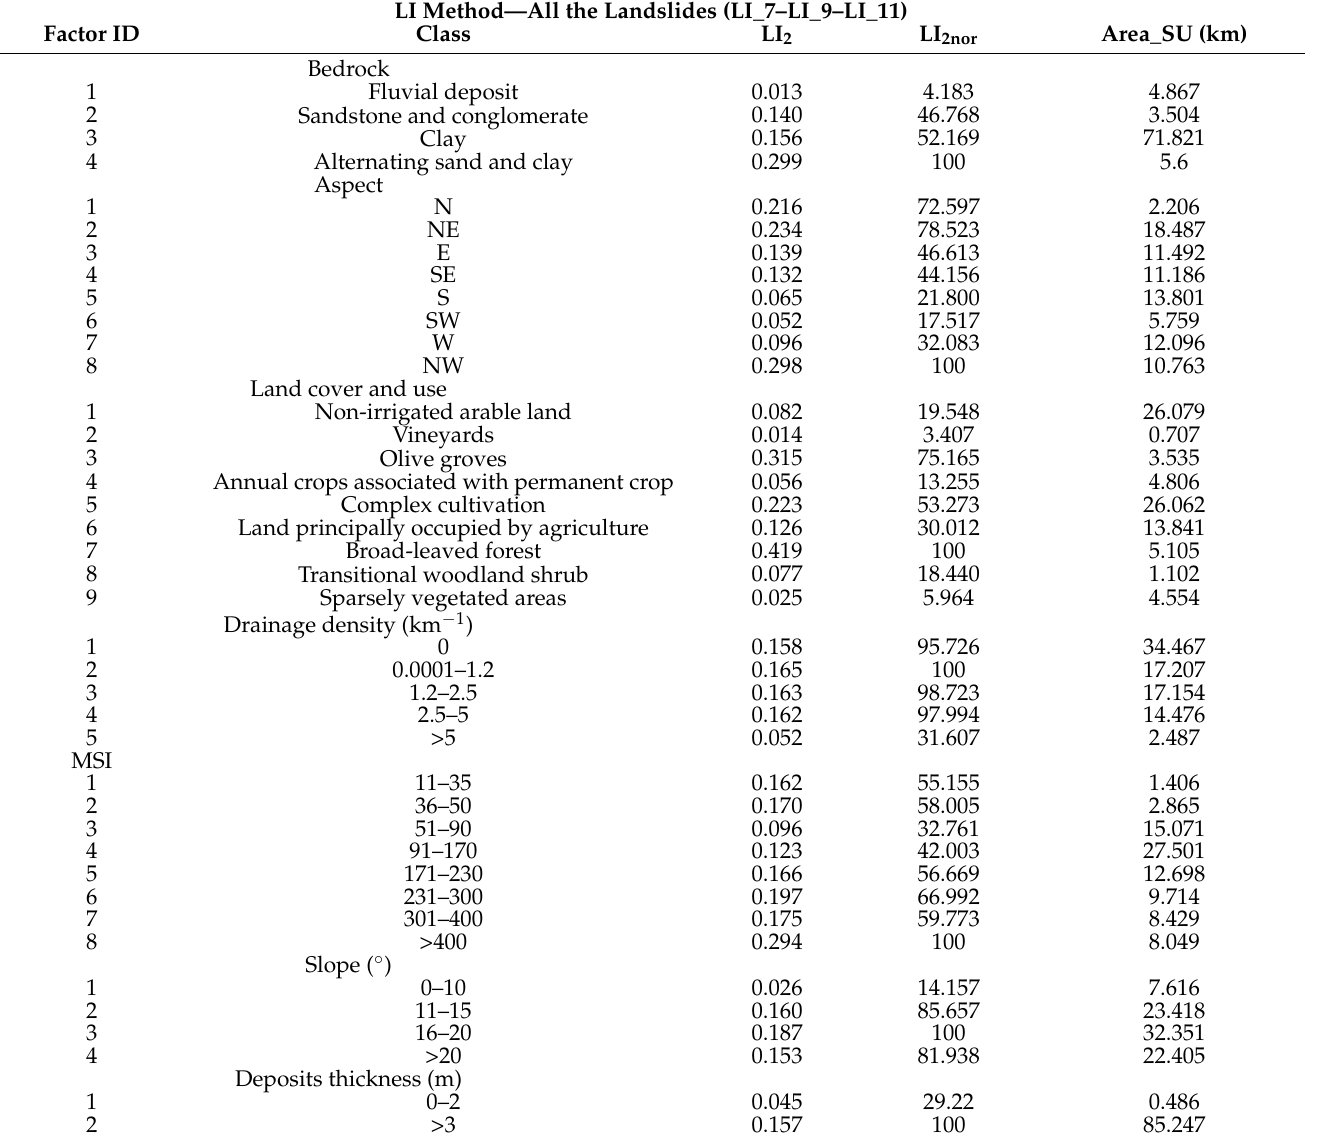
Table A5. Values of the parameters for deriving the LI for the models